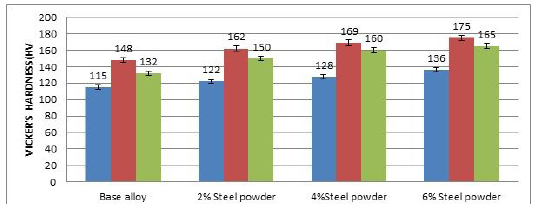
Figure 8. Peak hardness of Al 7075 eutectoid steel composite in hybrid (bainite)